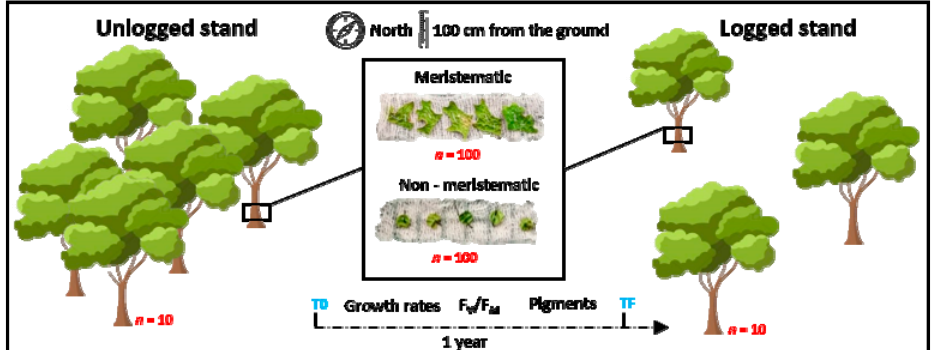
Figure 2. Graphical representation of the experimental design. n = 10 number of trees; n = 100 number of thallus fragments for each type; T0—time zero, beginning of the experiment; TF—final time, harvesting of the samples; F V / F M = the maximum of the quantum yield of primary photochemistry.